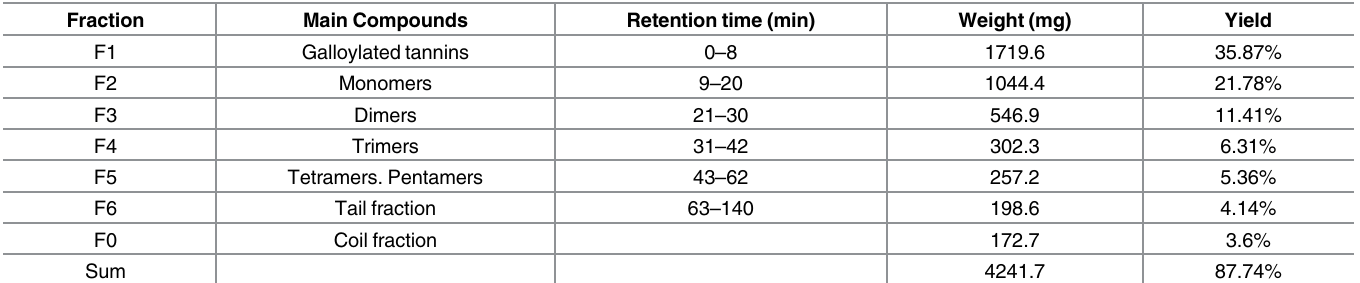
Table 1. Information on CPC